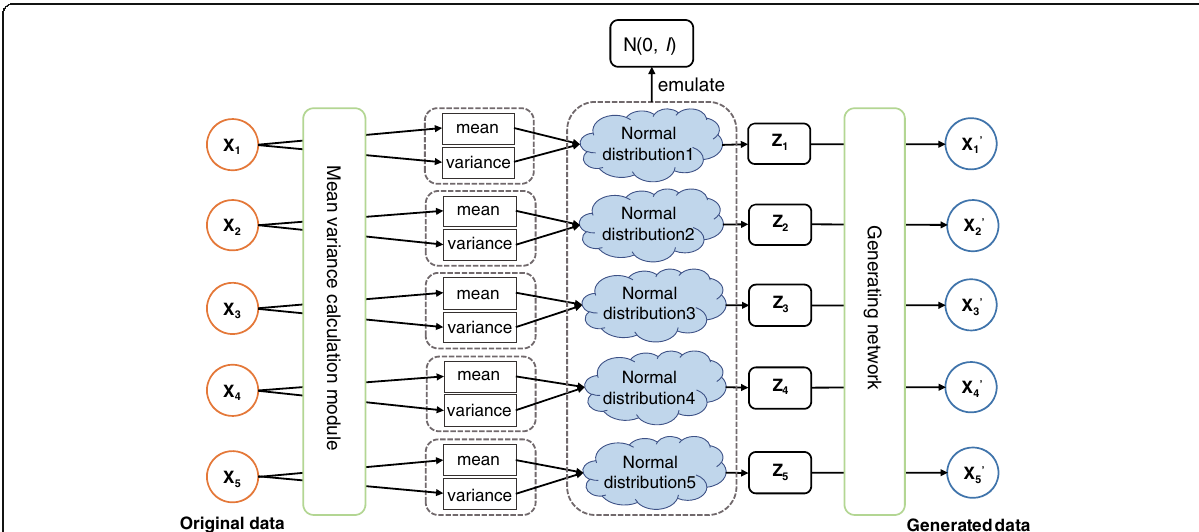
Fig. 1 Structure of the variational auto-encoder. The structure of the variational auto-encoder includes the encoding part and the decoding part. The encoding part is a mean variance calculation module, which includes two neural networks, one of which is used to calculate the mean and the other of which is used to calculate the variance. The decoding part restores the probability distribution of hidden variables to a probability distribution similar to the original data, which is called the generation